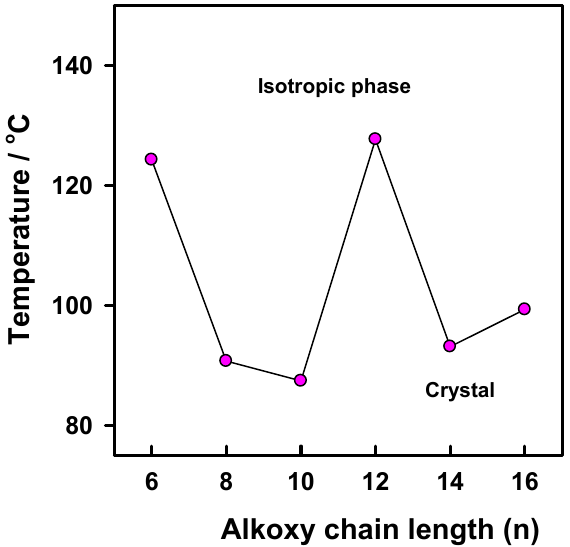
Figure 3. Dependency of alkoxy chain length (n) on the thermal properties of series I n